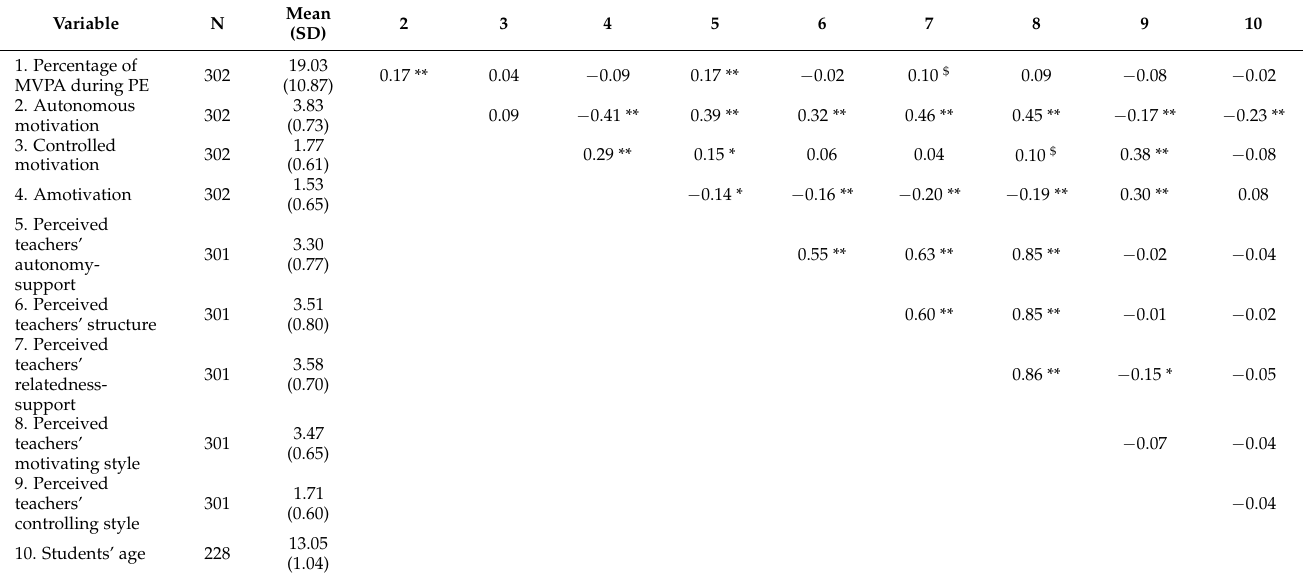
Table 1. Descriptive statistics and bivariate Pearson